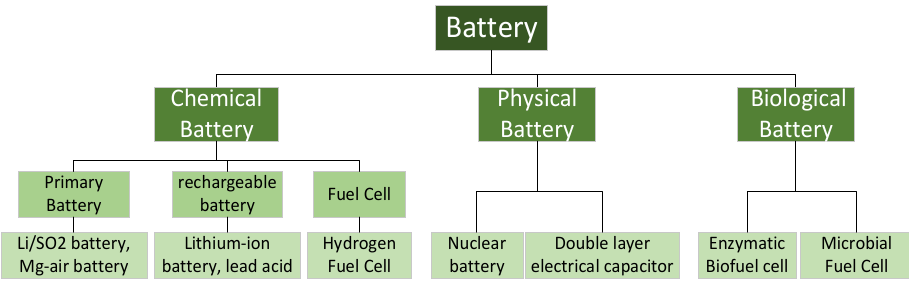
Figure 1. Battery classification chart.